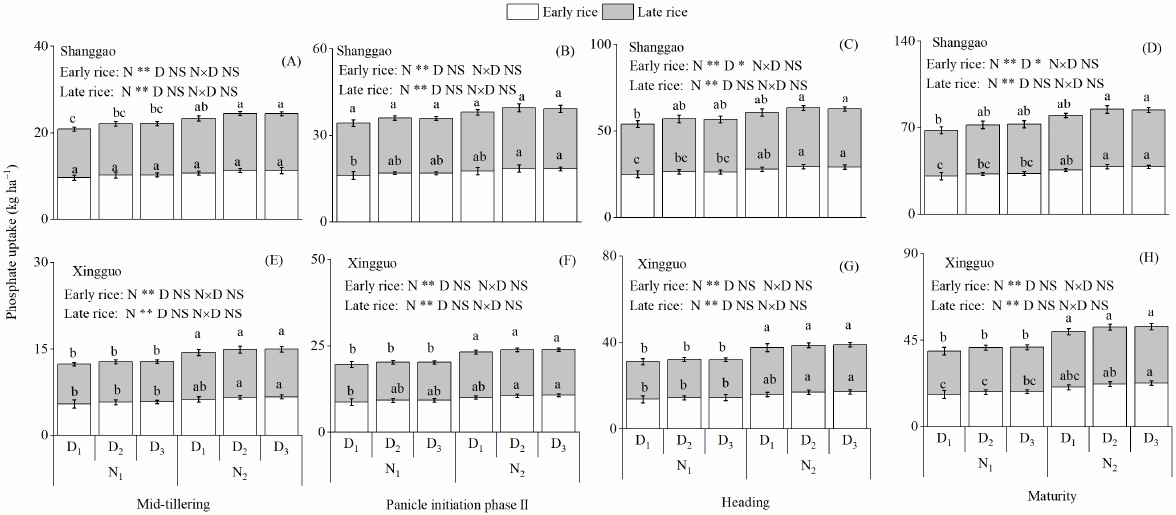
Figure 7. Phosphate absorption dynamics of double cropping rice ( A – H ) response to the N rate and plant density in two different ecological regions in 2018. N 1 and N 2 represent 120 and 150 kg ha -1 for early rice and N 1 and N 2 represent 120 and 165 kg ha -1 for late rice. D 1 , D 2 and D 3 represent 86, 143 and 200 plants per m 2 for early rice and D 1 , D 2 and D 3 represent 57, 114 and 172 plants per m 2 for late rice. Values followed by different lowercase letters are significantly different at the 0.05 level. NS, * and ** represent no significant difference and significant difference at the 5% and 1% levels.